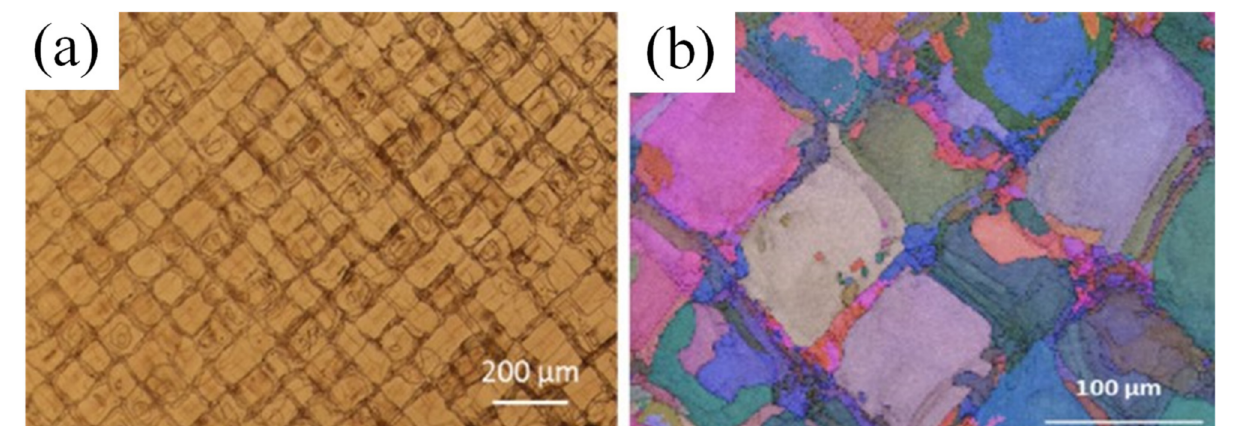
Figure 8. ( a ) Optical microscopy images and ( b ) grain orientation map of the laser-processed SAF2507 duplex steel. Reprinted with permission from ref. [212]. Copyright 2021